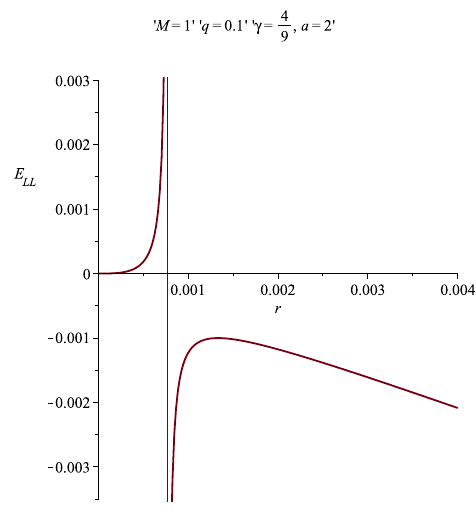
Figure 4. Landau-Lifshitz energy versus the radial distance r near the